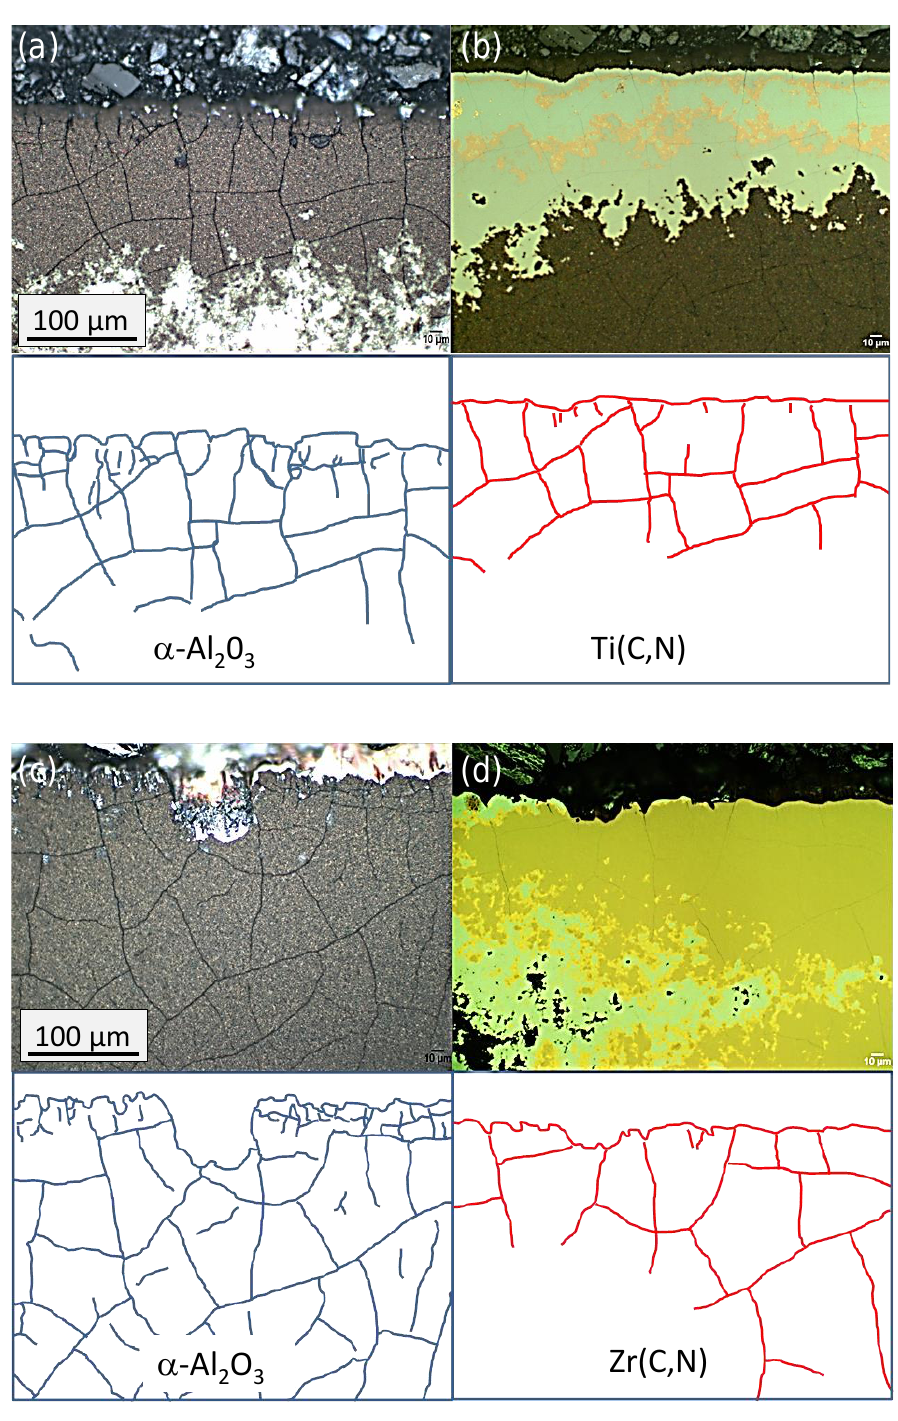
Figure 4. LOM images together with marked projection of comb crack network for the systems investigated after gentle polishing to reveal the comb cracks in the α-Al 2 O 3 ( a , c ) and the underneath carbonitride layer (Ti(C,N) ( b ) or Zr(C,N) ( d )). Images below represent better visualization of the cracks. Similar crack network in the α-Al 2 O 3 layer for both systems. The Ti(C,N) layer presents a more dense network of cracks compared to the Zr(C,N) layer.